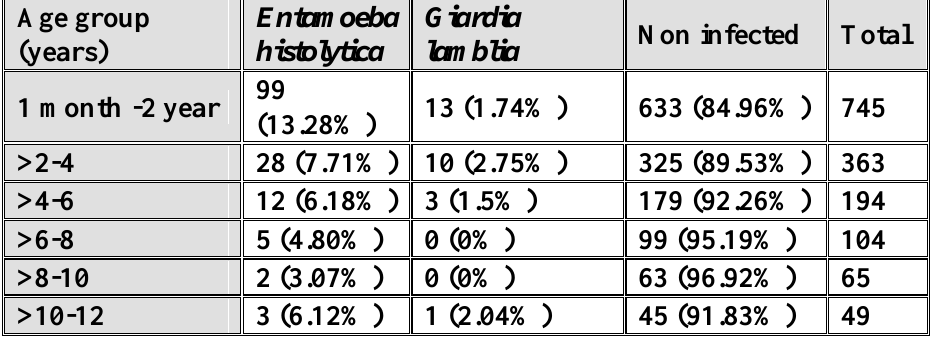
Table (2): Distribution of Entamoeba histolytica and Giardia lamblia according to the age